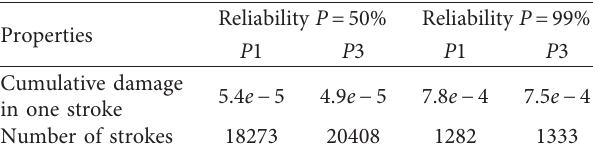
Table 7: Cumulative damage and fatigue life of multi-wire recoil